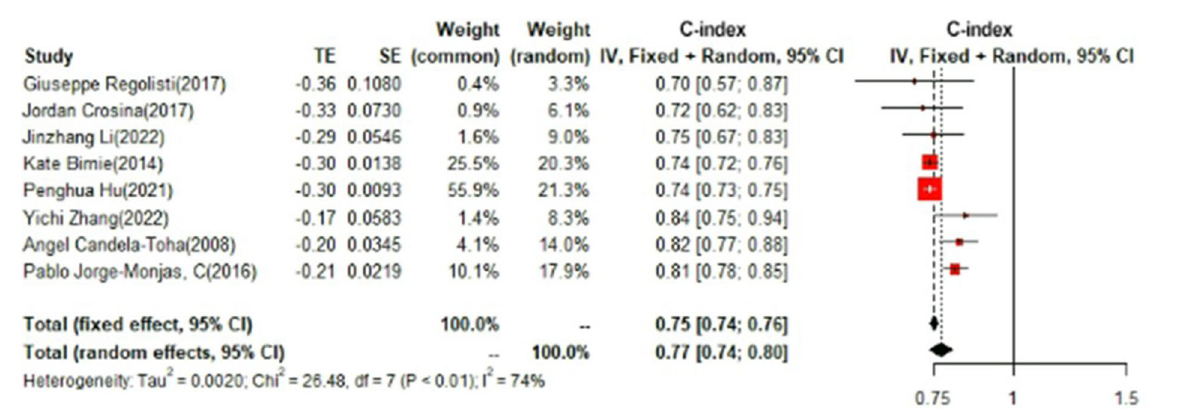
FIGURE9 C-index in the test set: logistic